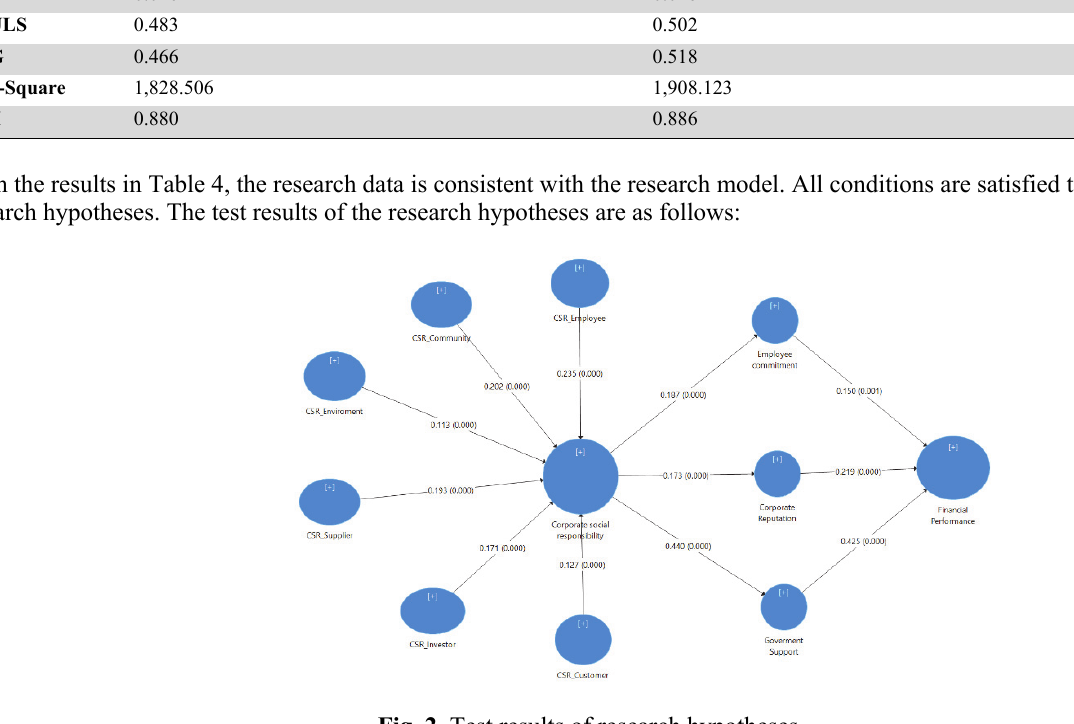
Fig. 2. Test results of research